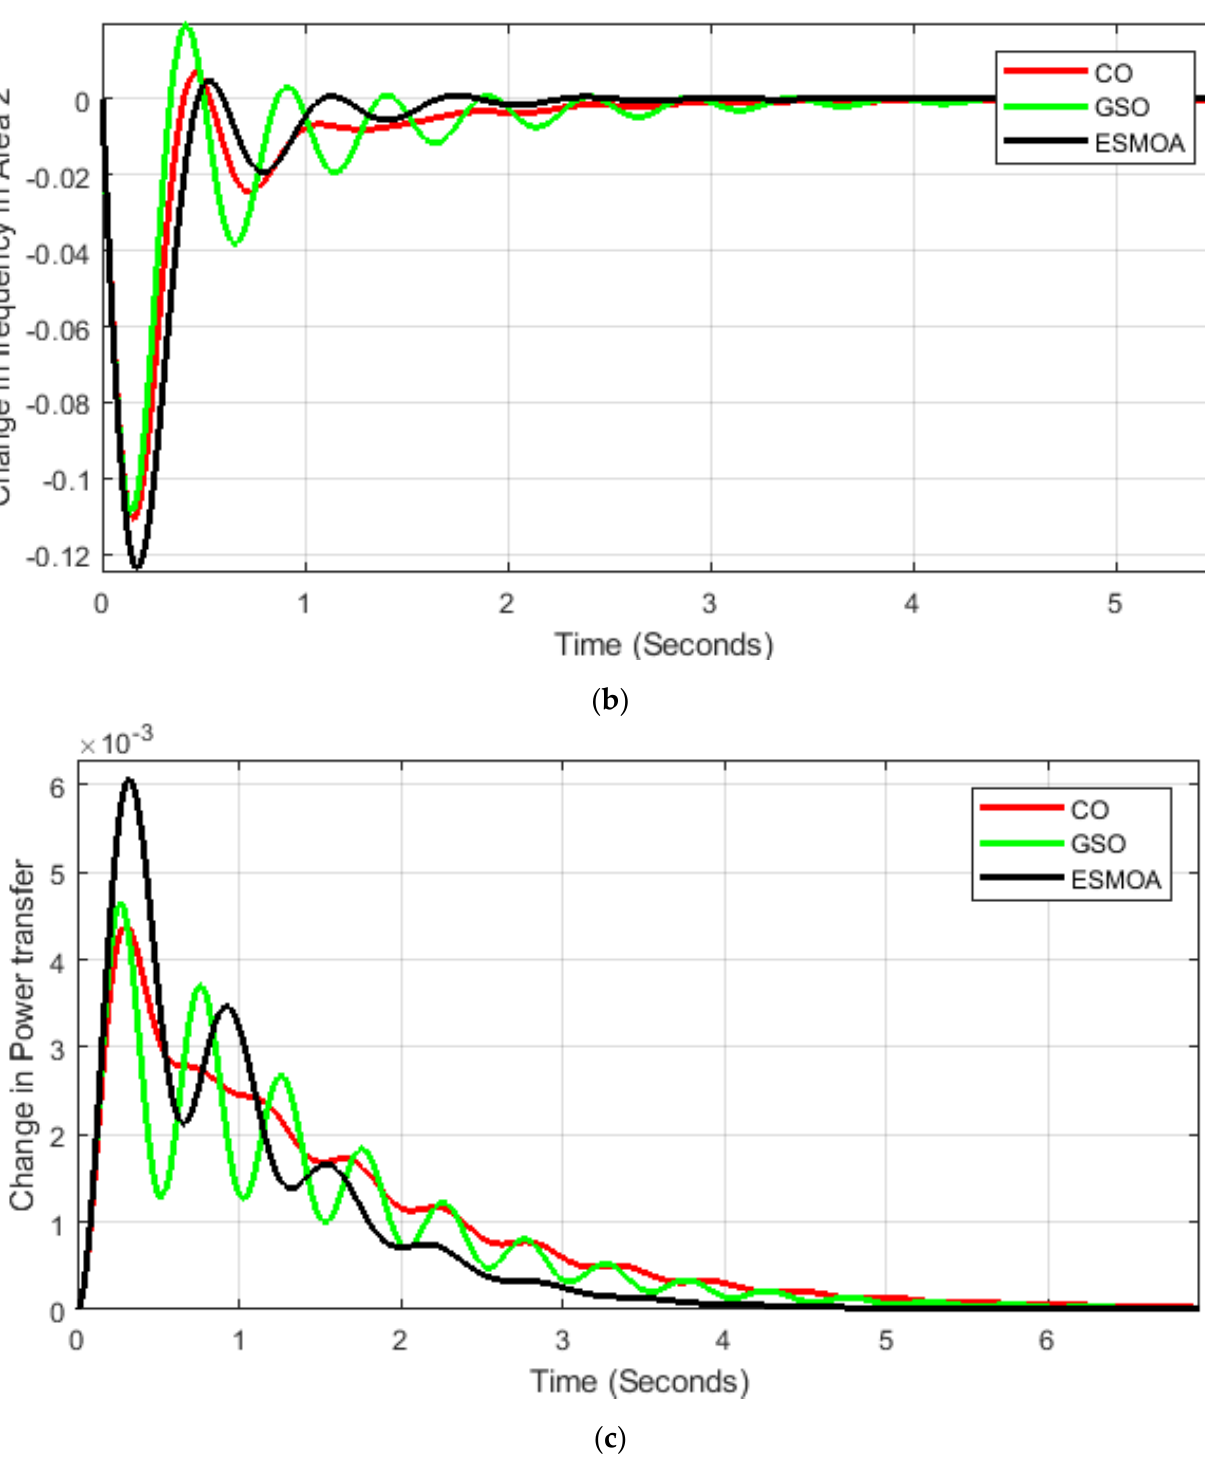
Figure 12. Dynamic responses for CO, GSO, and the proposed ESMOA for Case 3. ( a ) Deviation in frequency in area 1. ( b ) Deviation in frequency in area 2. ( c ) Deviation in transferred power through interconnected tie-line.